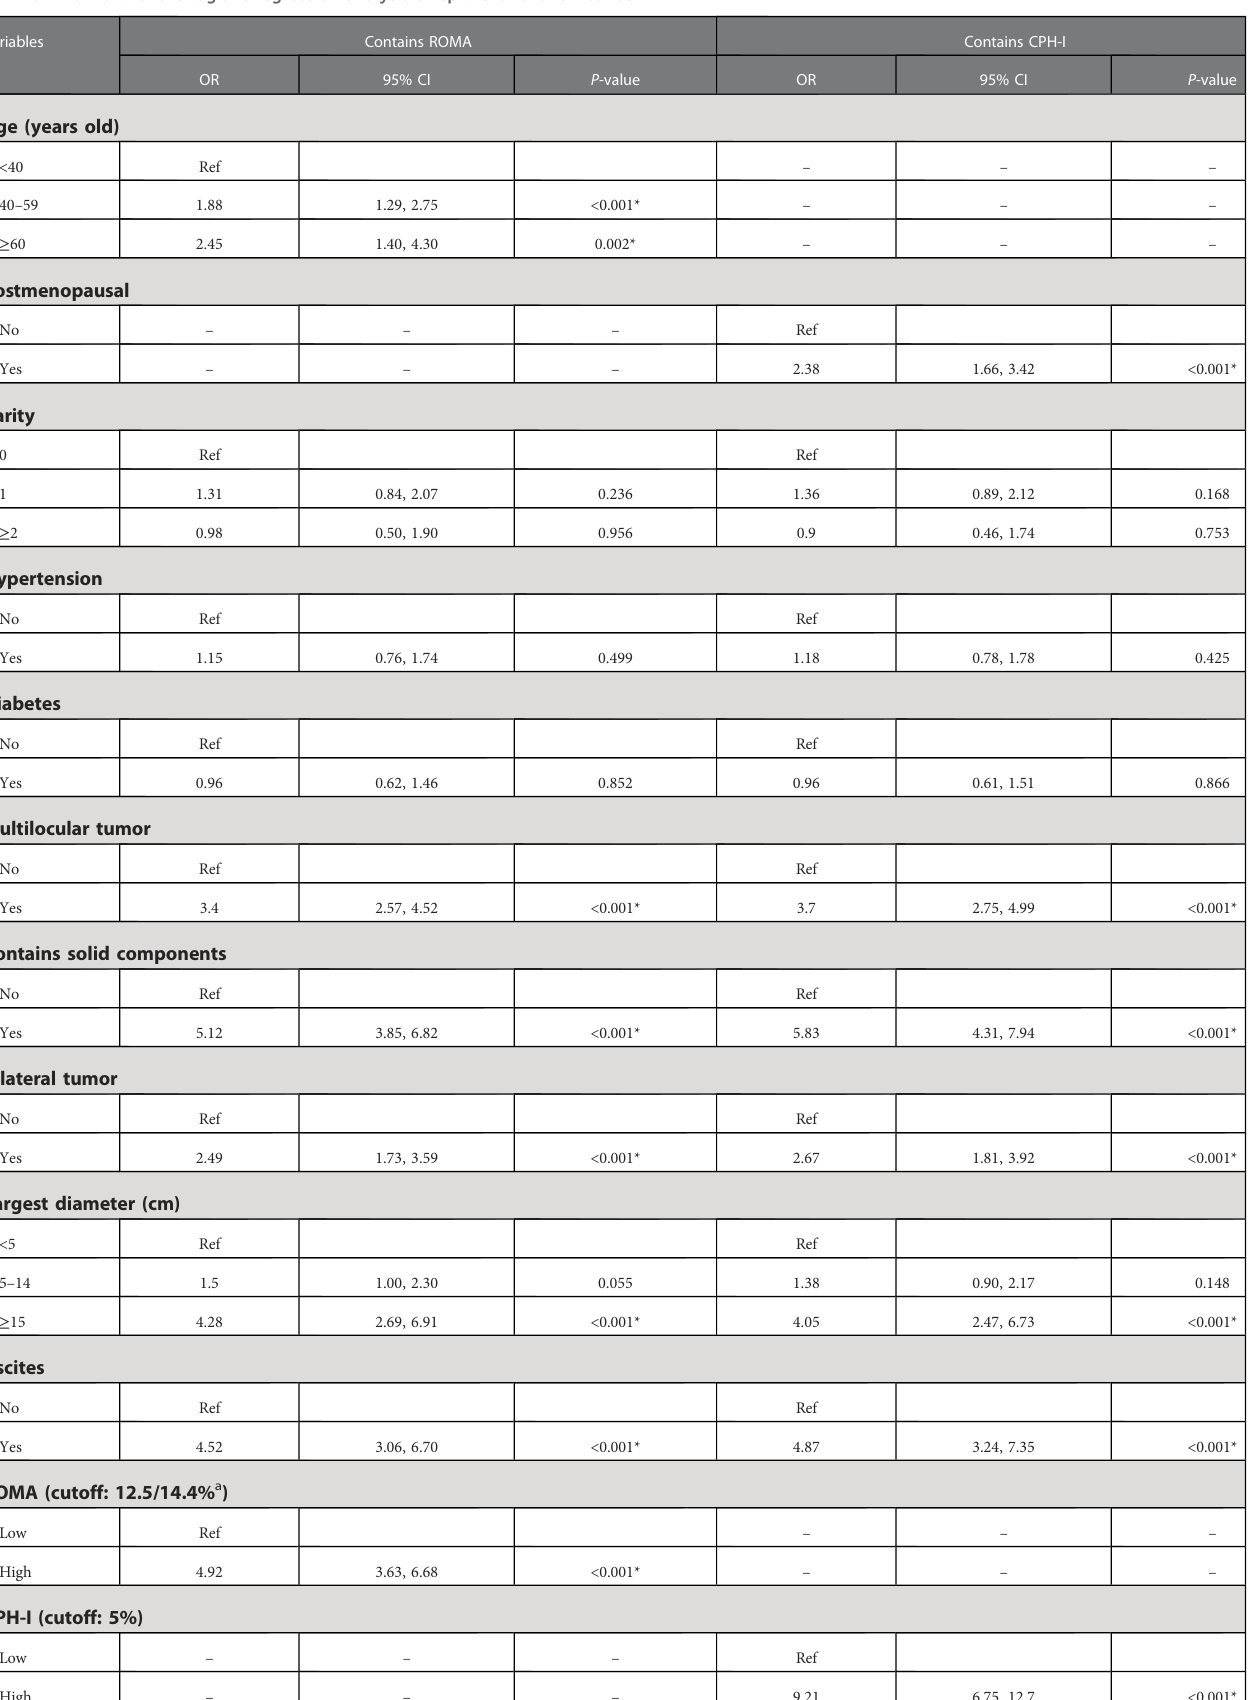
TABLE 3 The multivariate logistic regression analysis of epithelial ovarian